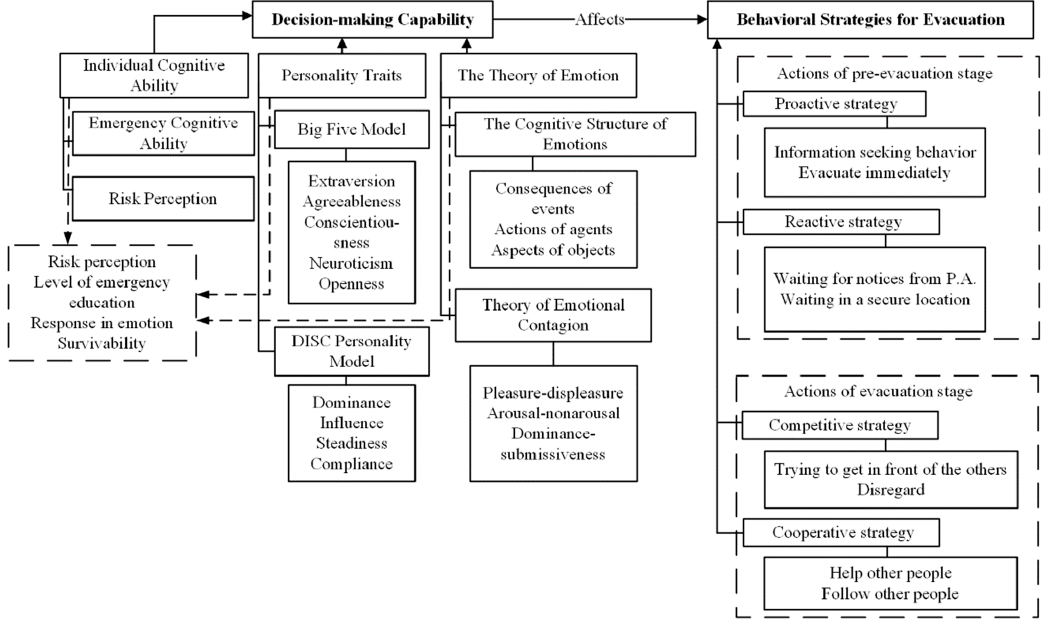
Figure 1. Components of the conceptual framework.